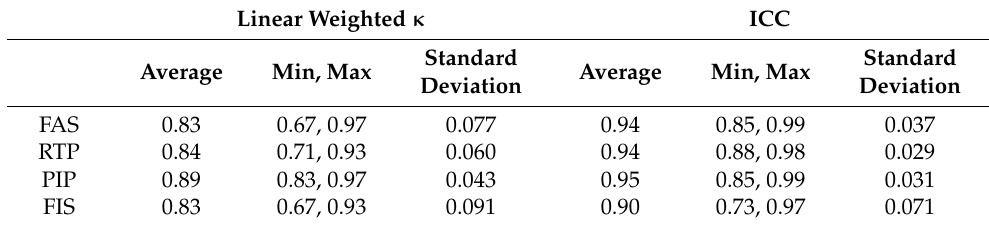
Table 4. Interobserver agreement and